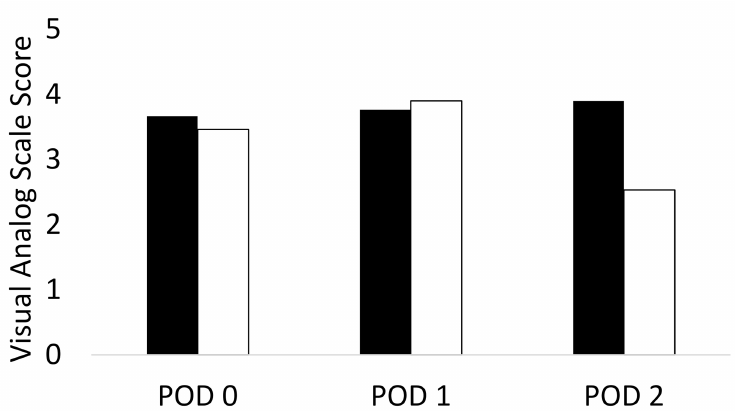
Figure 3. Variance in pain score on each post-operative day. Black bars = patient controlled analgesia; white bars = transversus abdominis plane block; POD = post-operative